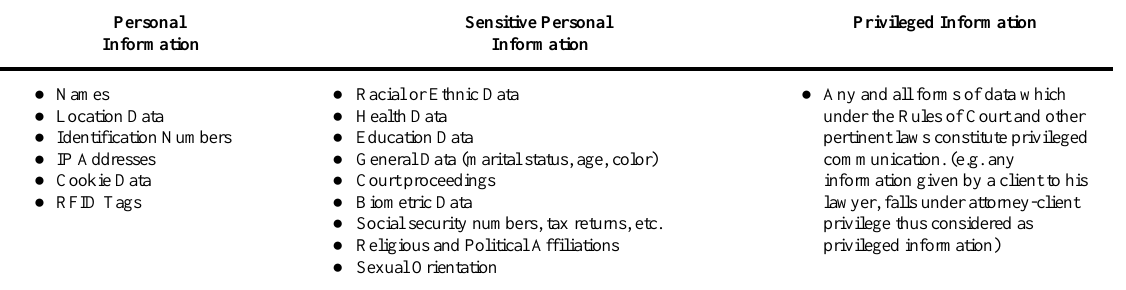
Table 2. Categories of Data under the Data Privacy Act of